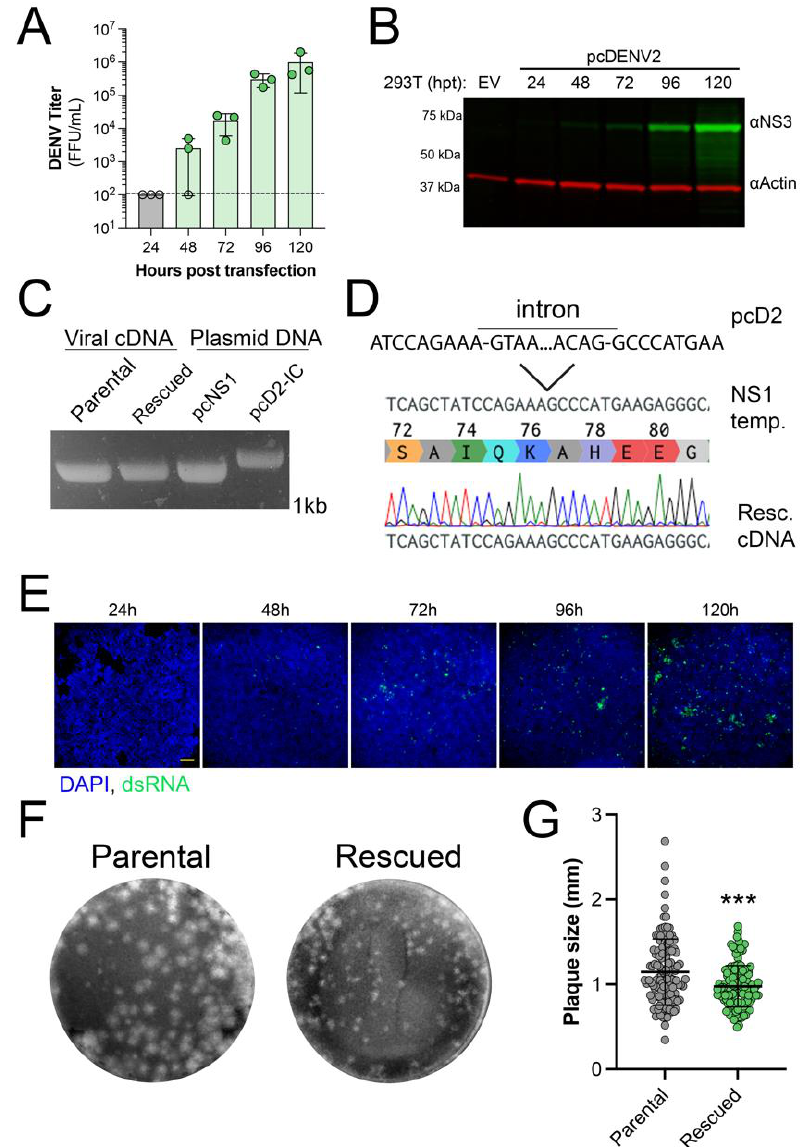
Figure 2. Rescue of DENV2. Validation of rescued virus. ( A ) Titer of DENV2 from pcDNA6.2 DENV 16681 transfected HEK 293T cells at indicated times post-transfection. Data represent the average FFU/mL ± SD of three independent transfections. Open circles represent samples below the limit of detection, shown by the dashed line. ( B ) Representative immunoblot of lysates from transfected HEK 293T cells collected at the indicated hours post-transfection (hpt). DENV NS3 is shown in green and actin is shown in red. The experiment was performed three independent times. ( C ) Representative agarose gel of NS1 PCR products for viral cDNA (parental and rescued) or plasmid controls (pcDNA-NS1 or pcDNA6.2 DENV2 16681). ( D ) Sequence alignment of the portion of NS1 containing the synthetic intron, WT NS1, and sequencing results of rescued virus cDNA, including the chromatogram. ( E ) Immunofluorescence staining of transfected HEK 293T cells fixed at the indicated time post-transfection. Viral dsRNA replication intermediate is shown in green and nuclei stained with DAPI are shown in blue. Scale bar represents 100 µ m. Representative images are shown from one of three independent experiments. ( F ) Representative images of plaque assays in BHK-21 cells. ( G ) Sizes for individual plaques (mm), n = 128, produced from parental and rescued virus infection. Individual plaque sizes are shown as data points with the average ± SD. Significance was determined by Student’s t -test, *** p <